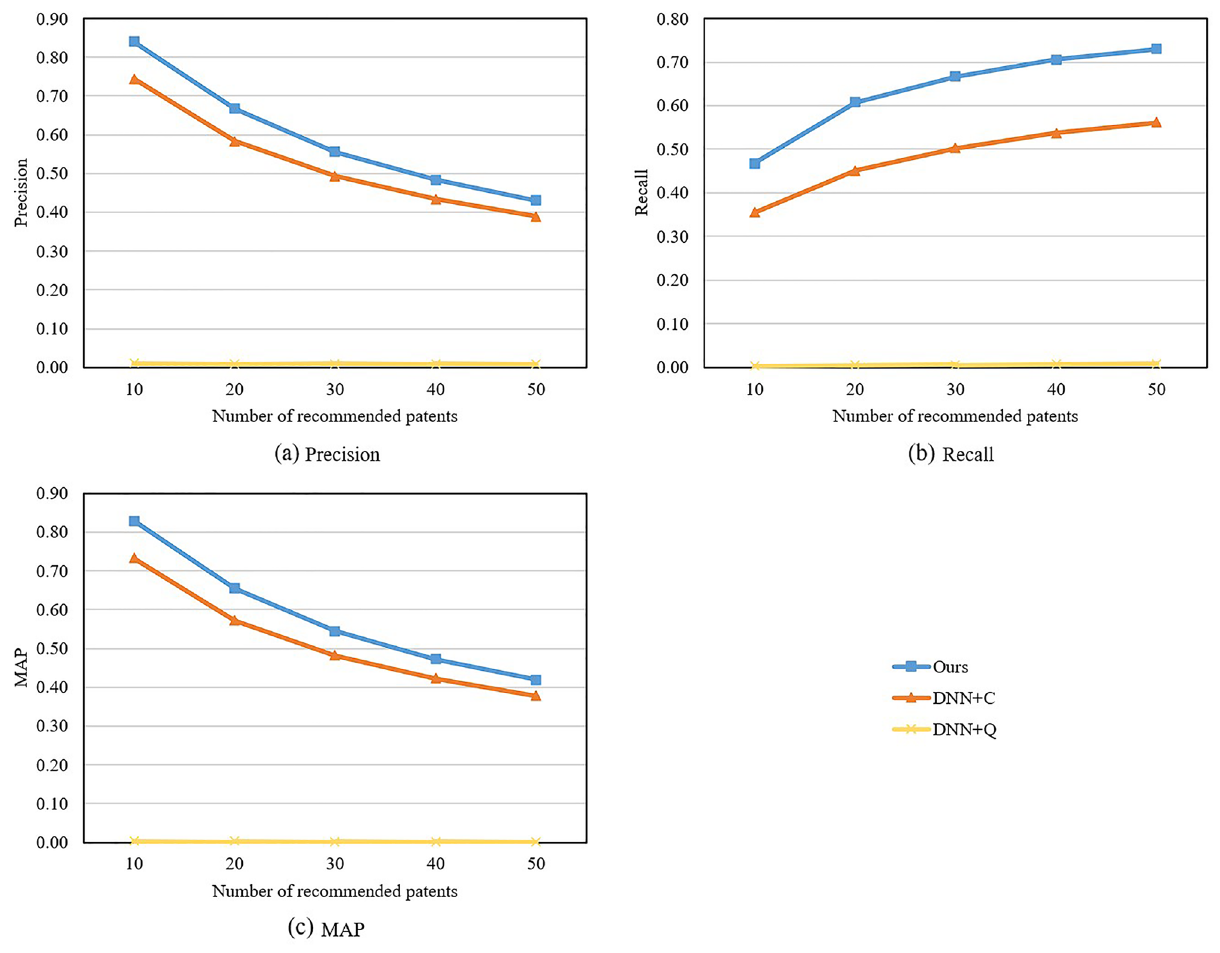
Figure 4. Recommendation performance of the proposed method with different